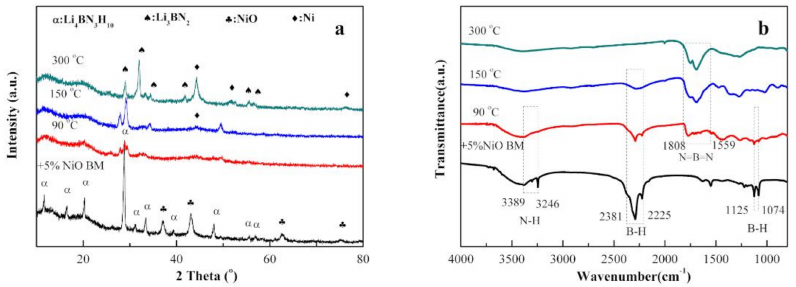
Figure 8. XRD patterns ( a ) and FTIR spectra ( b ) of the dehydrogenated LiBH 4 -2LiNH 2 -5 wt. % NiO.